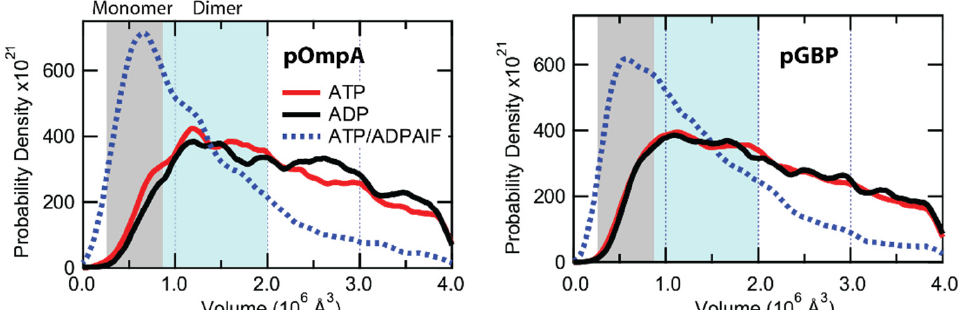
Figure 9. Oligomeric state changes with hydrolysis cycle. Volume distributions of translocases engaging pOmpA (left panel) with different nucleotides: ADP only (black curve, n = 1708), ATP only (red curve, n = 2518), or ATP followed by ADPAlF (blue dotted curve, n = 5088). Analogous volume distributions of translocases engaging pGBP (right panel) are also shown: ADP only (n = 2814), ATP only (n = 8441), or ATP followed by ADPAlF (n = 4973). The approximate monomer and dimer volume ranges of SecA are indicated by the gray-shaded region and blue-shaded region, respectively. Data are adapted from Ref.